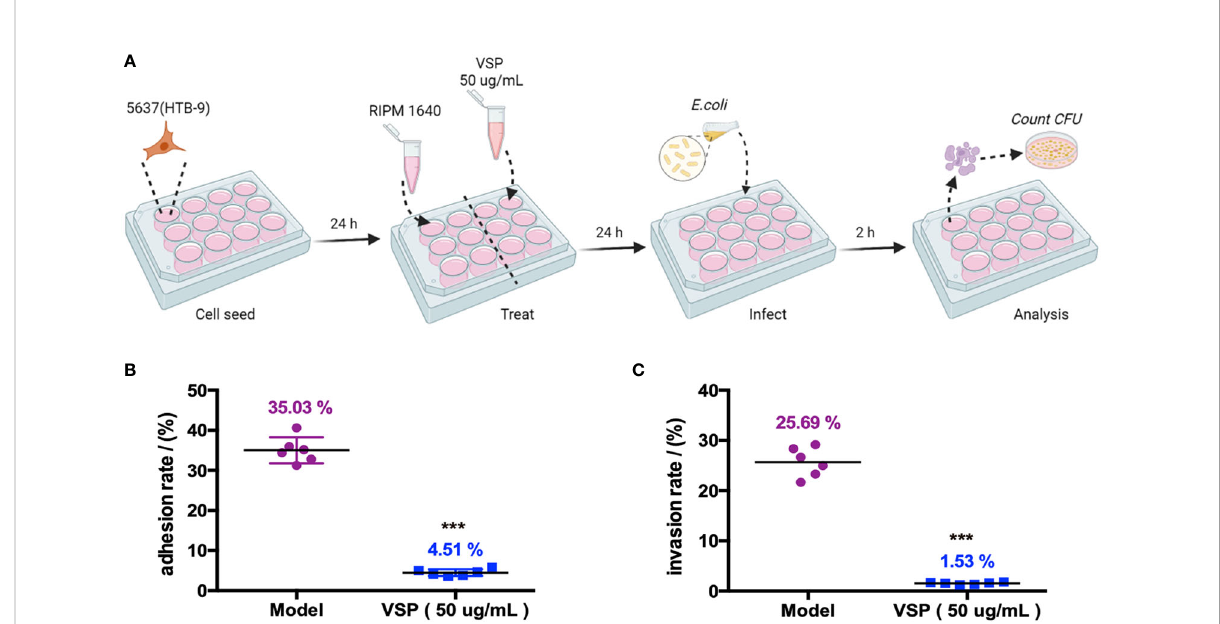
FIGURE 2 VSP inhibited the adhesion and invasion of UPEC CFT073 on the 5637 (HTB-9) cells. (A) , A scheme of the VSP administration and E. coli infection. (B, C) , The adhesion and invasion rates of UPEC CFT073 were assessed on MacConkey agar plates. Each symbol in this graph represents the value from one single group, and the geometric mean is shown as a horizontal line. n =6, compared with the model group: *** p < 0.001, the results were determined by the Mann-Whitney